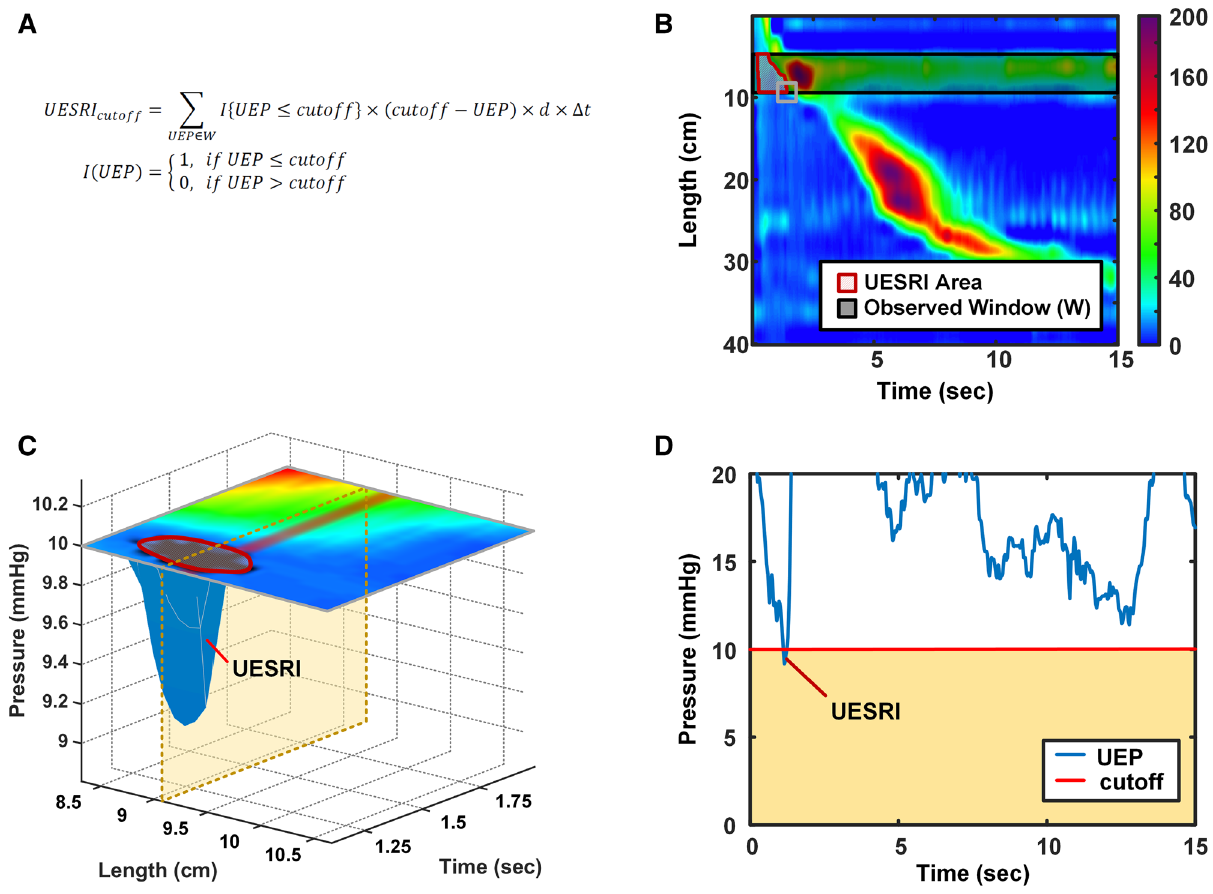
Figure 2. ( A ) In the formula of upper esophageal sphincter relaxation integral (UESRI), the “ UEP ” means upper esophageal impedance, “ d ” means the distance between two adjacent pressure sensors, “ Δt ” is the sampling interval, “ W ” is the observed window, and “ I ” is the indicator function. ( B ) The 2 D plot of UESRI of the wet swallow. ( C ) The 3D plot of UESRI of the wet swallow. ( D ) Calculation of the UESRI value at less than 10 mmHg.